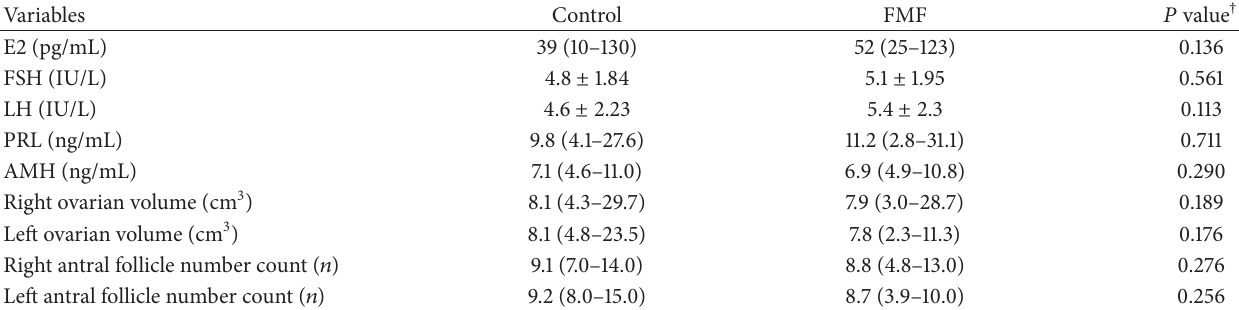
Table 2: Laboratory results, AMH levels, ovarian volumes, and antral follicle numbers of the groups. Variables